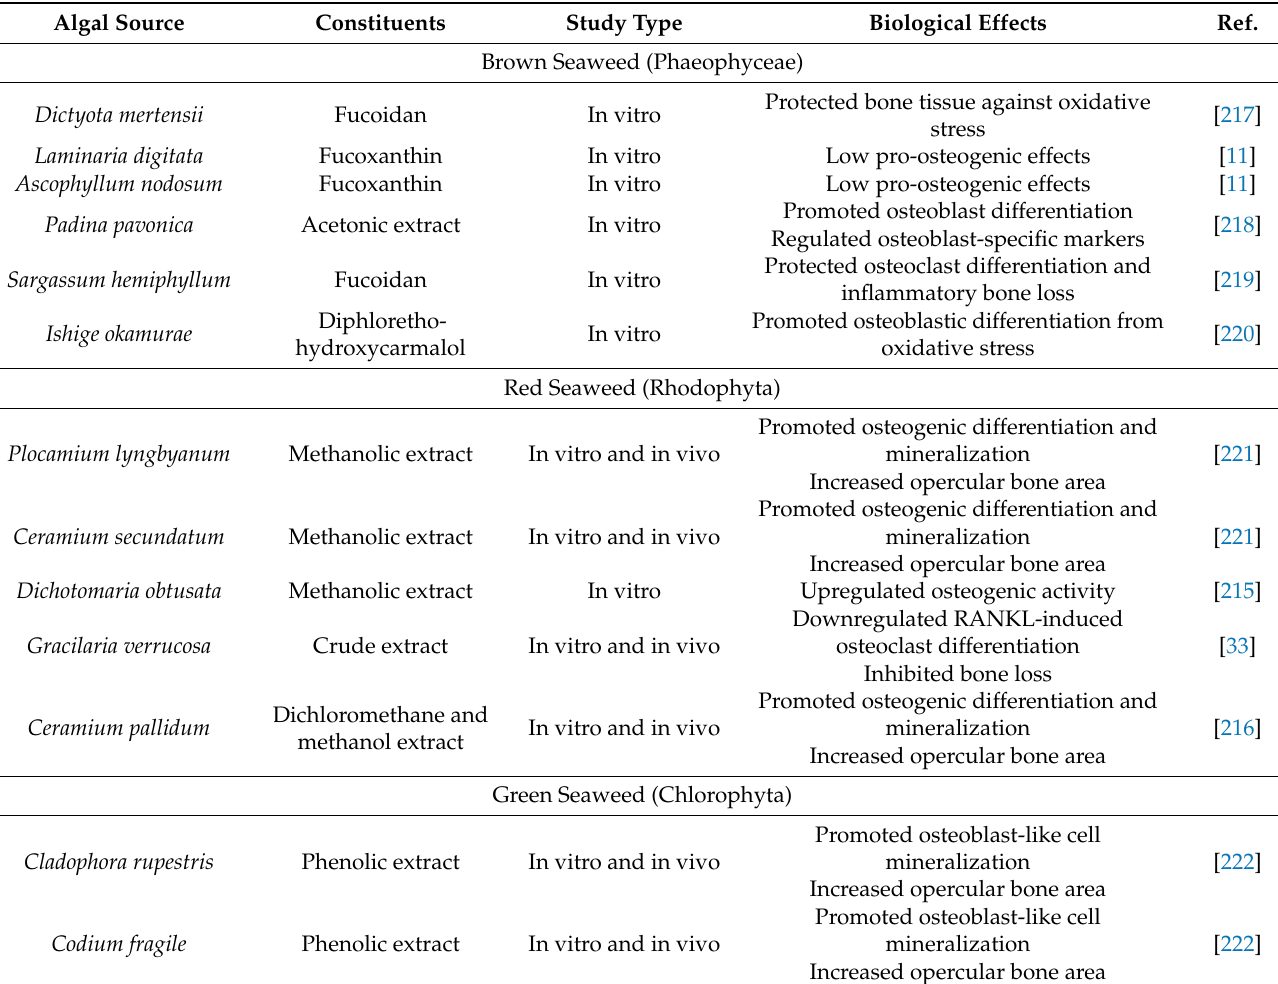
Table 8. The effect of seaweed-derived compounds on